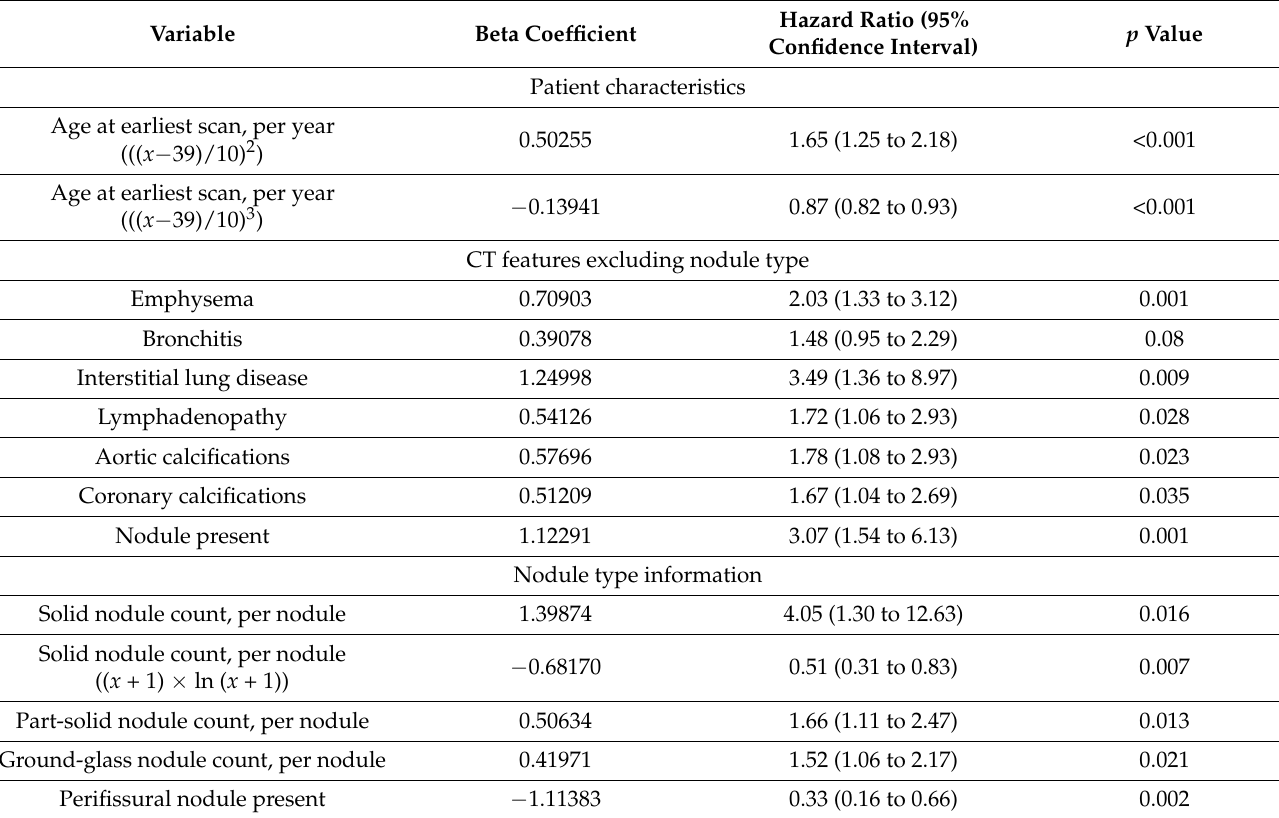
Table 2. Parsimonious lung cancer risk model (Nodule Type